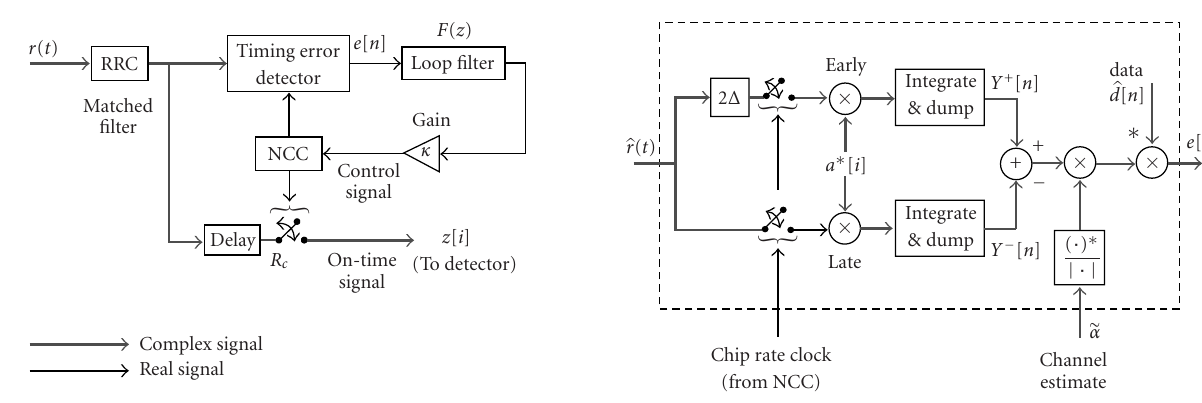
Figure 2: Generic delay-locked loop structure. Figure 3: Single-antenna coherent timing error